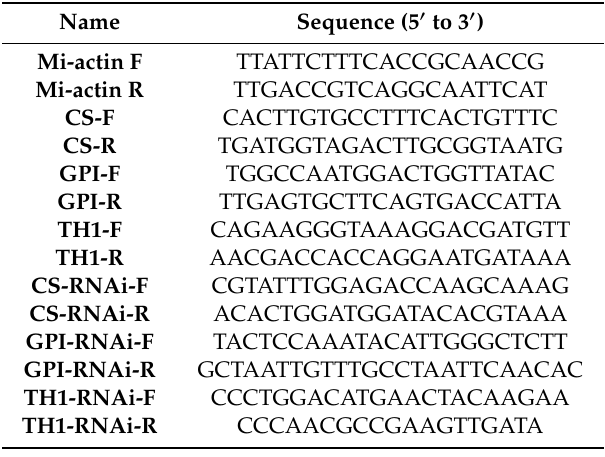
Table 4. List of primers used for qPCR